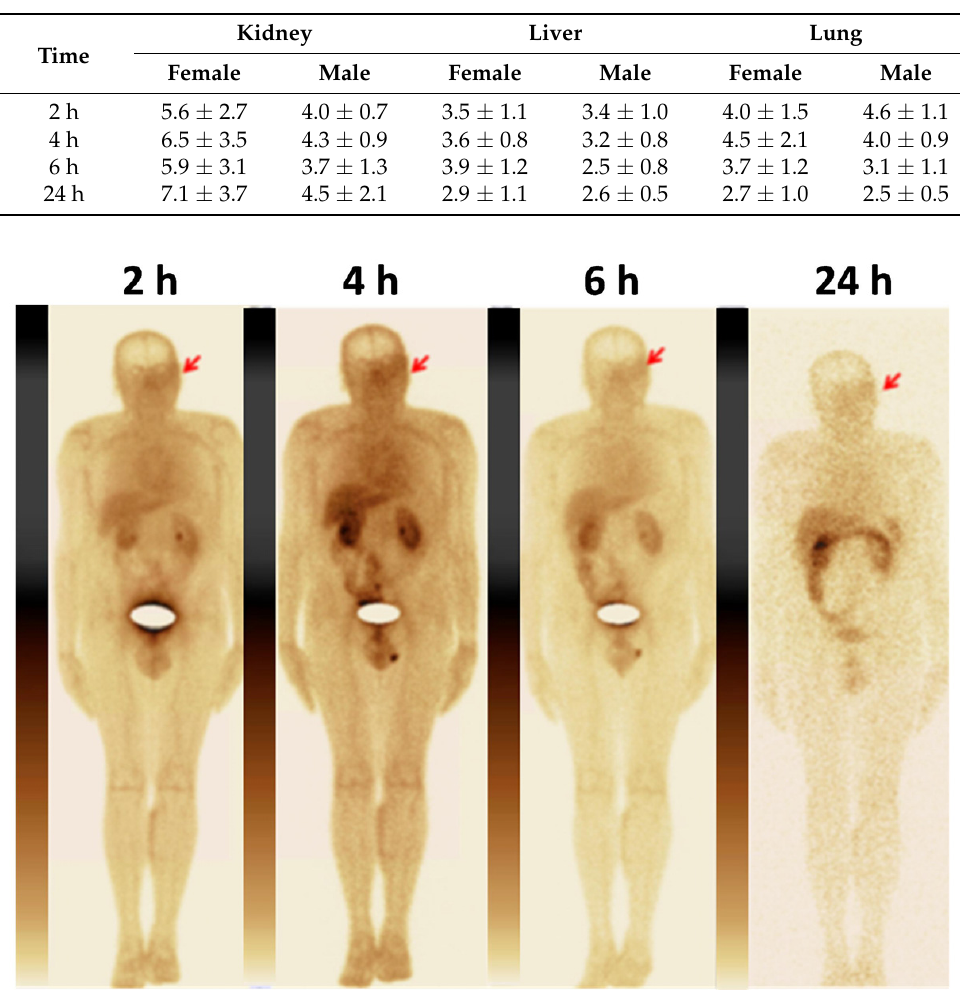
Figure 2. Anterior images of patient 7 (male) at 2, 4, 6 and 24 h after injection of [ 99m Tc]Tc-TG. Activity in the urinary bladder is masked. The upper setting of the scale window is 100% of the maximum counts.